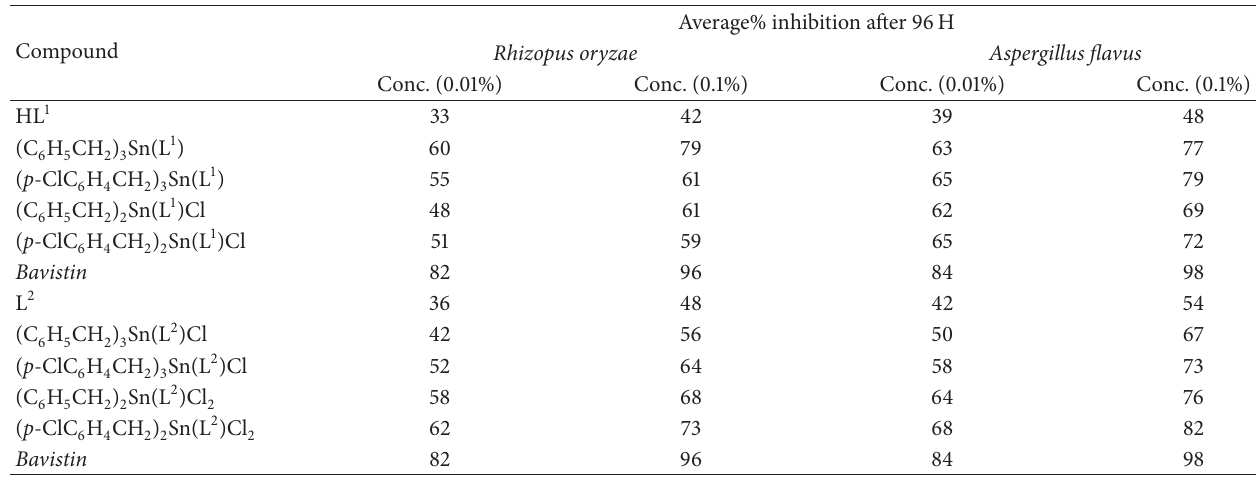
Table 7: Antifungal activity of theophylline and theobromine